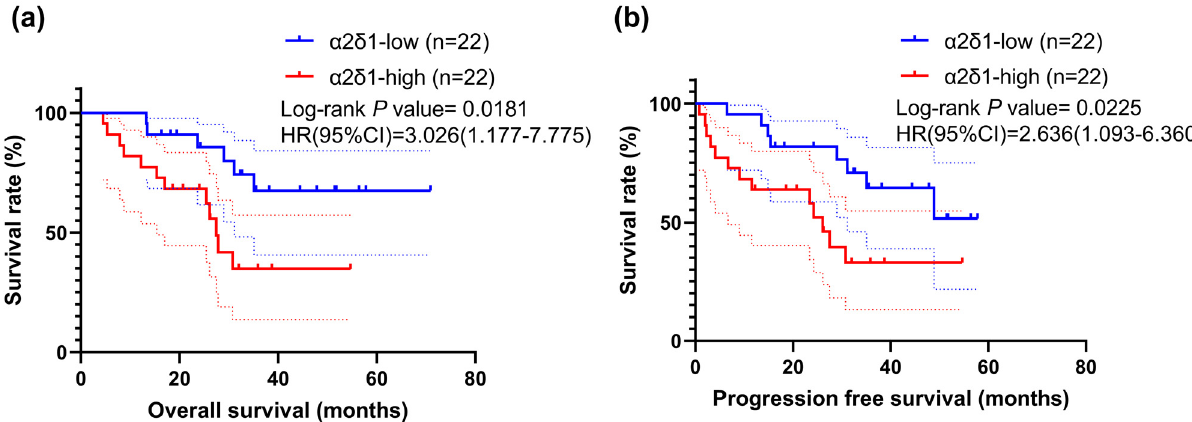
Figure 2: Kaplan – Meier curves for overall survival and progression free survival in HSCC patients ( n = 44 ) . ( a ) High α 2 δ 1 expression groups had signi fi cantly lower OS than low α 2 δ 1 expression groups. ( b ) High α 2 δ 1 expression groups had signi fi cantly lower PFS than low α 2 δ 1 expression groups. Hazard ratio ( HR ) and its 95% con fi dence interval, and Log - rank P value are